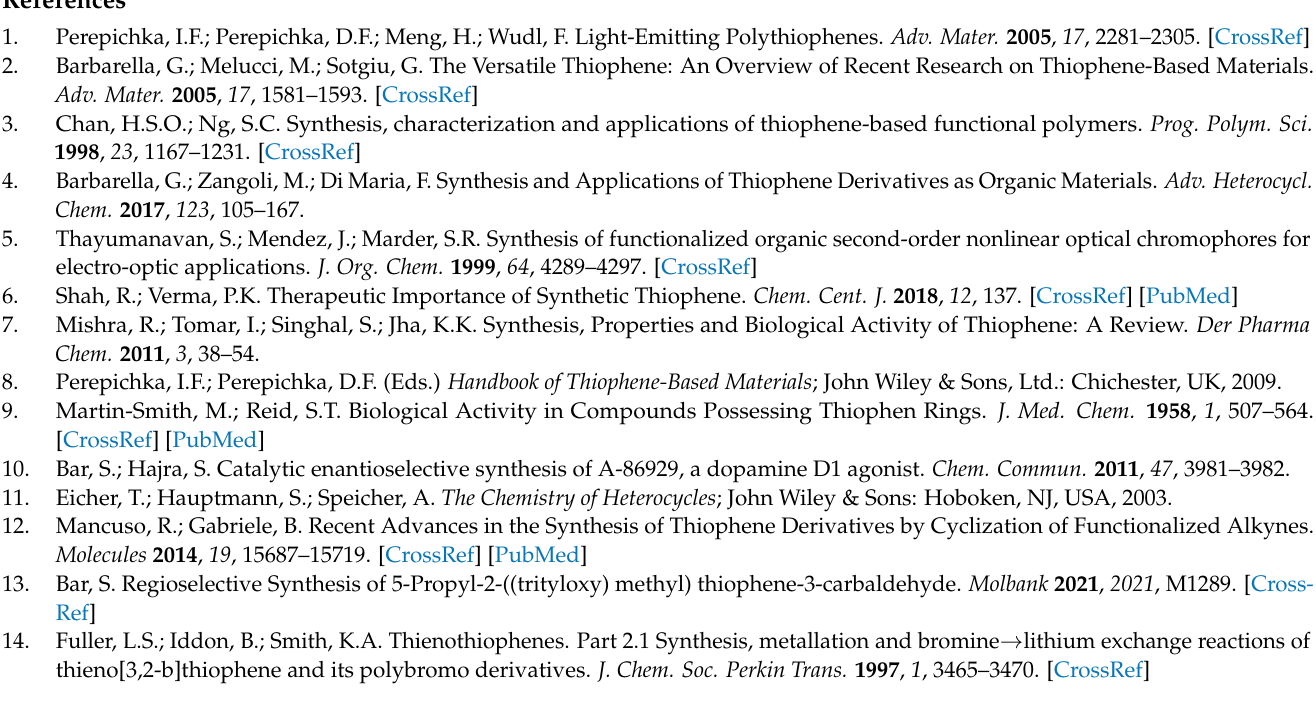
H-NMR spectrum of compound 5 ; Figure S10: 13 C-NMR spectrum of compound 5 ; Figure S11: DEPT-135 spectrum of compound 5 ; Figure S12: LCMS analysis (chromatogram and ionization) compound 5 ; Figure S13: LCMS analysis (mass, negative mode) compound 5 ; Figure S14: LCMS analysis (chromatogram and ionization) compound 3 ; Figure S15: LCMS analysis (mass,